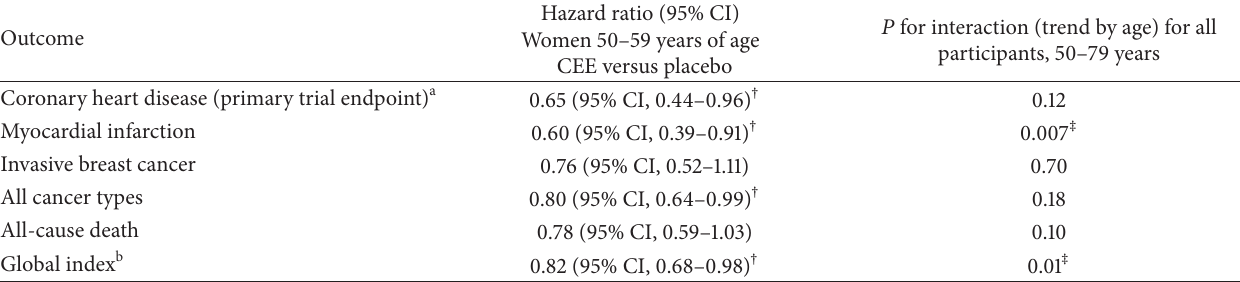
Table 2: Women 50–59 years of age at trial entry: WHI Estrogen-Alone Trial outcomes, 13-year cumulative long-term follow-up (intervention phase + postintervention